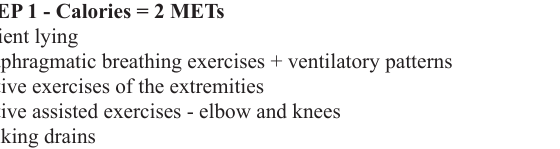
STEP 1 - Calories = 2 METs Patient lying Diaphragmatic breathing exercises + ventilatory patterns Active exercises of the extremities Active assisted exercises - elbow and knees Milking drains STEP 2 - Calories 2 METs Patient sitting Diaphragmatic breathing exercises + ventilatory pattern Exercises with ventilatory incentive + Flutter Active exercises of the extremities Active exercises of the lower limbs (quadriceps) Milking drains STEP 3 - Calories 3-4 METs Patient standing Active exercises of the elbow and ends Active stretching of lower limbs (quadriceps, adductors, hamstrings and triceps) Mark steps with knee Ambulation: 35 meters Exercises with ventilatory incentive STEP 4 - Calories 3-4 METs Patient standing Passive stretching of active upper and lower limbs Active exercises of the extremities Active exercises of the lower limbs (flexion/extension and abduction/adduction) Exercises with incentive spirometry Ambulation: 60 meters Walking downstairs training (1 st floor) STEP 5 Calories = 3-4 METs Patient standing Passive stretching and active upper and lower limb Active exercises of the extremities Active exercises of the lower limbs (flexion/extension and abduction/adduction) Exercises with incentive spirometry Ambulation: 100 meters Walking downstairs training (1 st floor) STEP 6 Calories = 3-4 METs Patient standing Passive stretching of upper and lower limb active Active exercises of the extremities